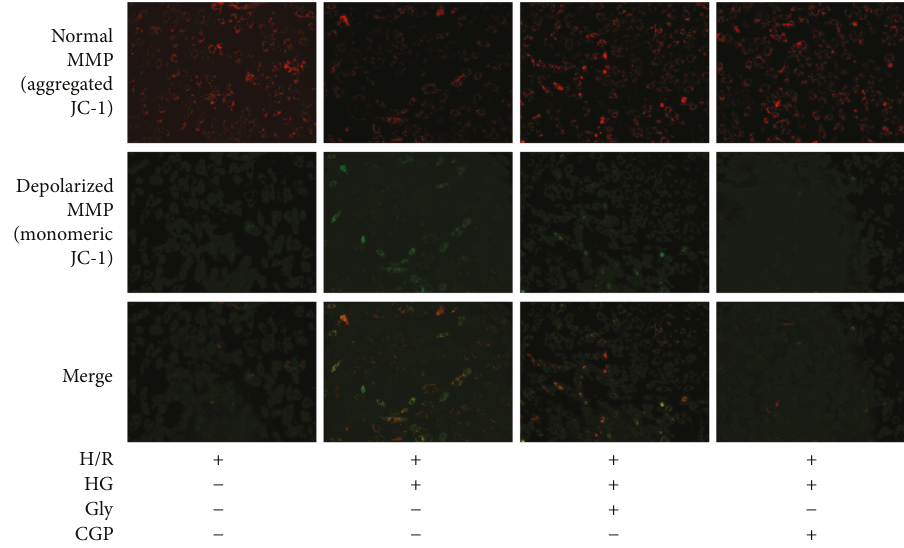
Figure 4: E ff ects of glycine (Gly) and CGP53353 (CGP) on mitochondrial membrane potential (MMP) in H9C2 cells subjected to high glucose (HG) and hypoxia/reoxygenation (H/R) insult.